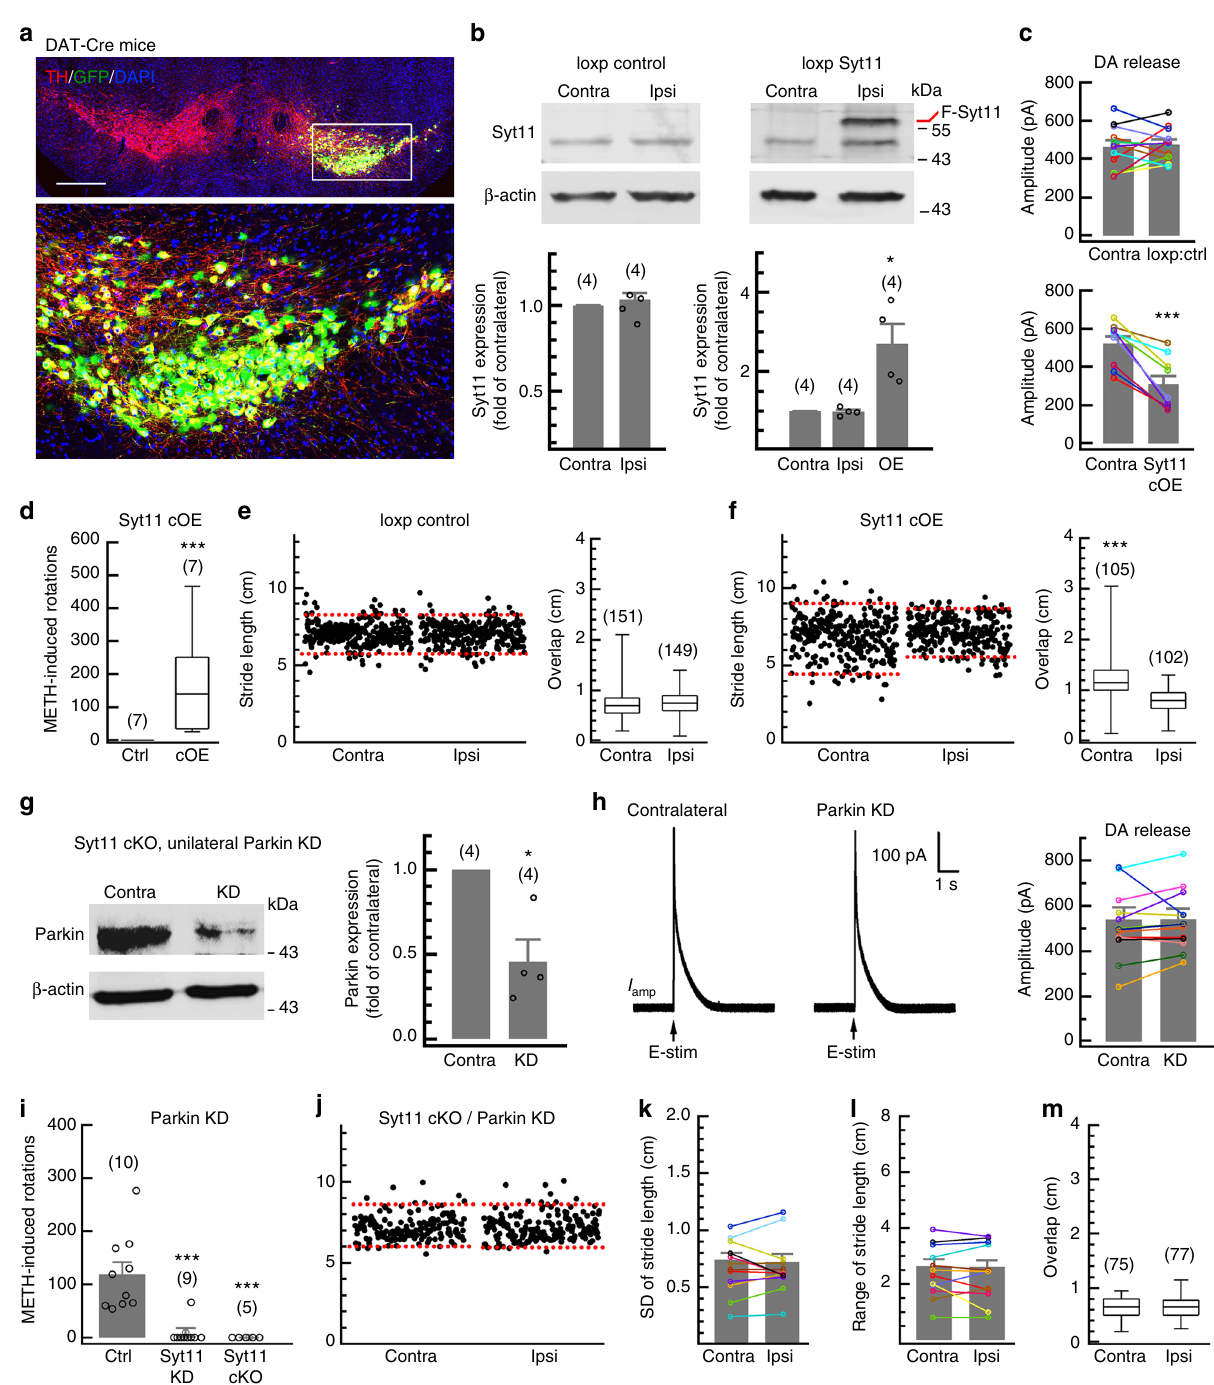
Fig. 8 Expression of Syt11 in dopaminergic neurons is critical for parkin to mediate DA release and motor de fi cits. a Representative micrograph of TH staining in an SNpc-containing slice from DAT-Cre mice unilaterally injected with Cre-inducible Flag-Syt11 (or GFP control) overexpressing AAV9 virus. Scale bar, 500 μ m. b Representative western blots and statistics showing the expression of Syt11 and Flag-Syt11 (F-Syt11, OE) in the bilateral SNpc from Syt11 cOE mice 1 month after virus injection. c Statistics of DA release in the striatum of Syt11 cOE mice ( n = 12 slices from fi ve control mice and nine slices from four Syt11 cOE mice). d METH-induced asymmetric rotation (in 90min) of control (Ctrl) and Syt11 cOE mice. e , f Footprint gait analysis of Syt11 cOE and loxp control mice; dashed red lines show the 5 and 95% percentiles of stride length. n represents steps from seven control ( e ) or six Syt11 cOE mice ( f ). g Representative western blots and statistics showing the ef fi ciency of parkin KD in the SNpc of Syt11-cKO mice. h Representative amperometric currents and statistics showing the unchanged DA release in the striatum of Syt11-cKO mice with unilateral parkin KD in the SNpc ( n = 13 pairs in slices from fi ve mice). i METH-induced asymmetric rotation of control mice with unilateral parkin KD or parkin/Syt11 double-KD in the SNpc, and that of Syt11-cKO mice with unilateral parkin KD. j – m Footprint data showing that unilateral parkin KD in the SNpc fails to induce a motor defect in the contralateral limbs of Syt11-cKO mice ( n = 75 Contra and 77 Ipsi steps from fi ve mice). Dashed red lines show the 5 and 95% percentiles of stride length in j . Data are shown as mean ± s.e.m for b , c , g – l . Paired Student ’ s t -test for b lower left, c , g , h , k , l ; one-way ANOVA for b lower right, i ; Mann-Whitney test for d – f , m , box and whisker plots show medians (central line in the box), ranges between 25th and 75th percentiles (box) and minimum – maximum ranges (whiskers). * P < 0.05, *** P <